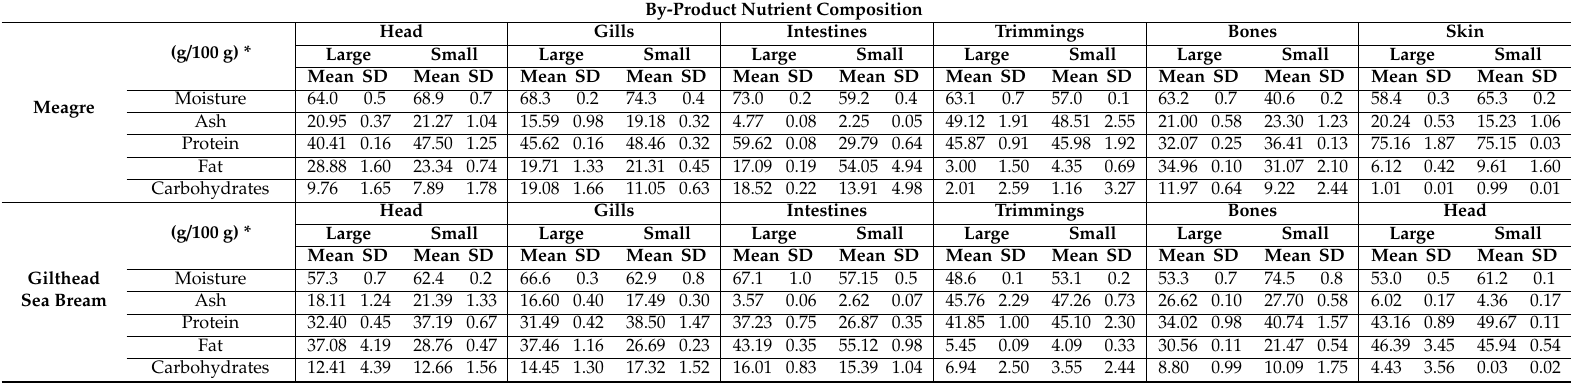
Table 2. Mean data for the nutrient composition of by-product samples (head, gills, intestines, trimmings, bones, skin) of meagre and gilthead sea bream fishes in two di ff erent size classes (large and